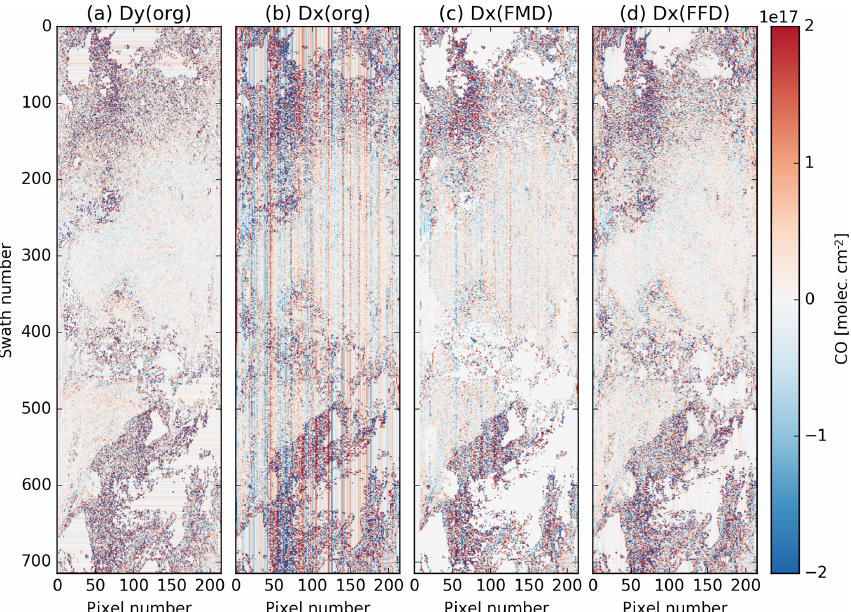
Figure 9. CO retrievals of one TROPOMI orbit on 28 July 2018 (partly shown). From left to right – (a) derivative Dy( d ) along-track direction of the original data, (b) Dx( d ) derivative in the cross-track direction of the original data, (c) Dx( d d s ) after FMD destriping and (d) is the same as (c) but after FFD destriping.